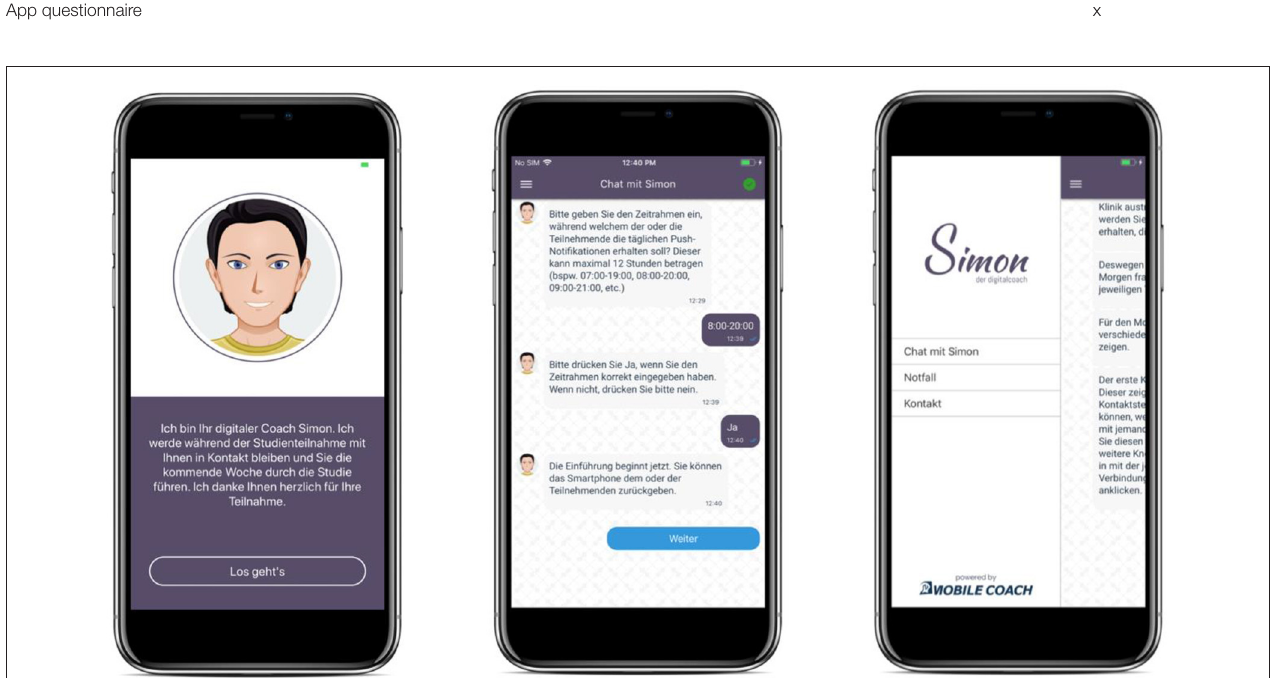
FIGURE 2 | The SIMON-SELF application: welcome screen (left) , the chat screen (middle) and the menu (right) .